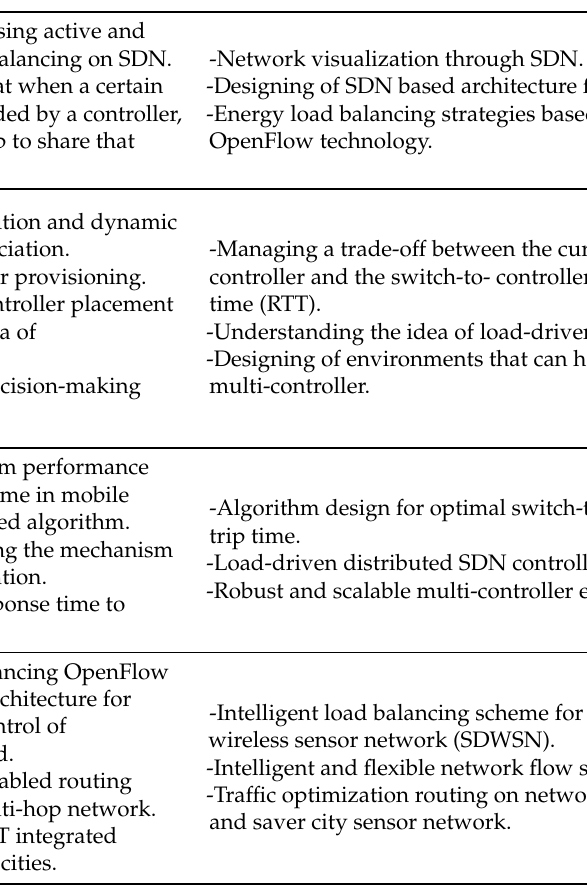
Table 2. A summary of intelligent load balancing techniques in the SDN based on research challenges, existing solutions and research directions.